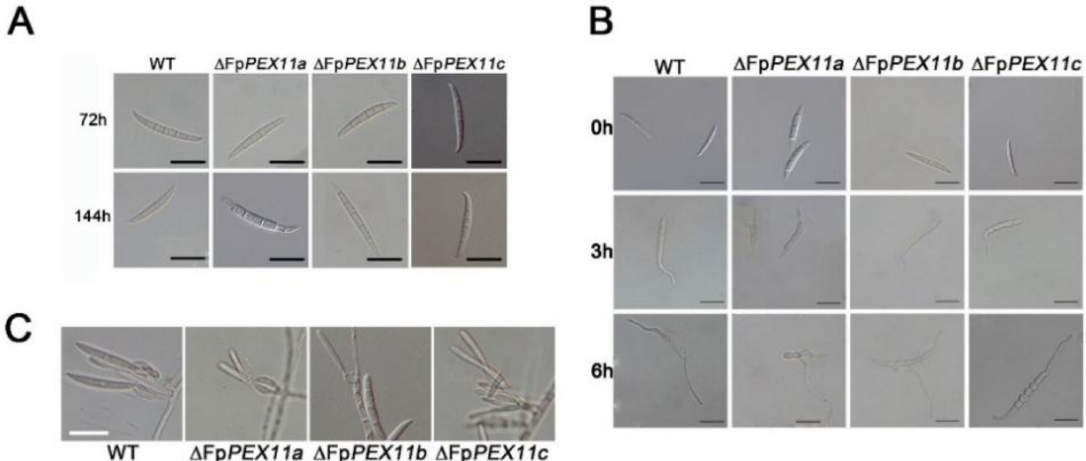
Figure 3. Asexual reproduction assay in WT and ∆ FpPEX11 strains in F. pseudograminearum. ( A ) Coni- dia of WT and the mutants incubated in liquid CMC for 3 days. ( B ) Strains were incubated in YEPD culture medium for 3 h or 6 h. Scale bar = 20 µ m. ( C ) Conidiogenous